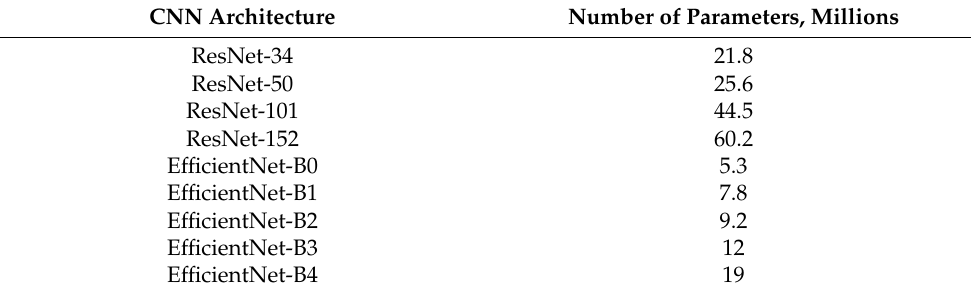
Table 2. Number of parameters in different CNNs.